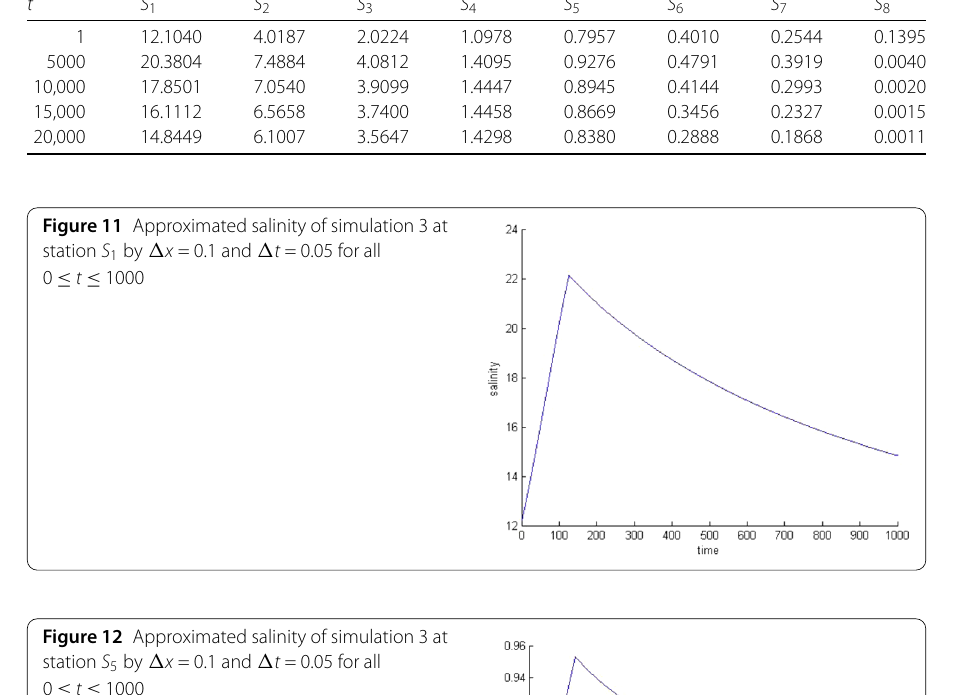
Figure 12 Approximated salinity of simulation 3 at station S 5 by (cid:4) x = 0.1 and (cid:4) t = 0.05 for all 0 ≤ t ≤ 1000